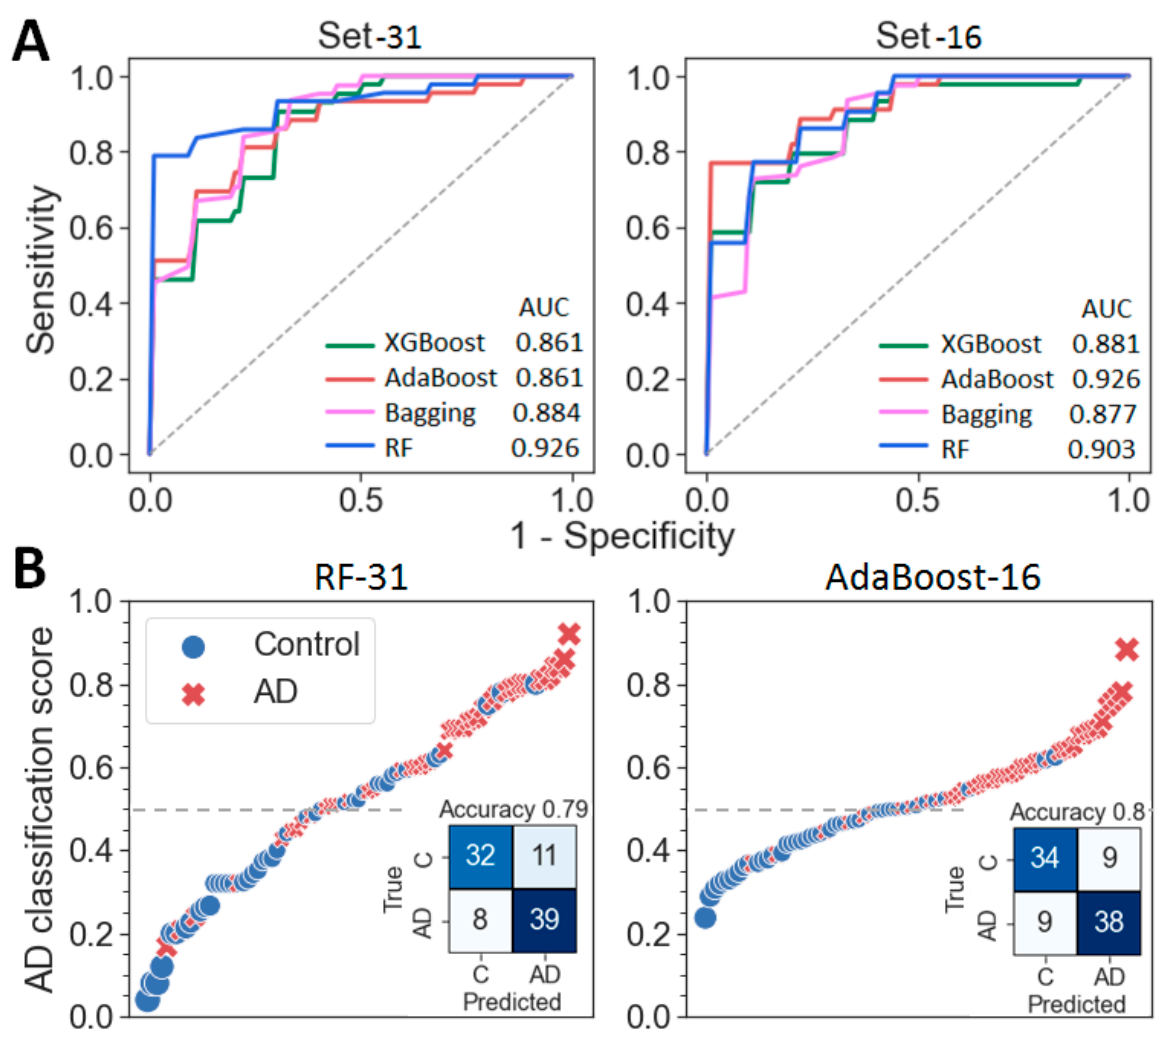
Figure 4. Differentiation of the AD and control samples using the obtained protein panels and developed classifiers. ( A ) ROC curves for the differentiation of AD vs. the controls for classifiers generated with 4 algorithms and 2 sets of proteins. ( B ) Distribution of the control and AD samples according to the probability of AD using two classifiers with the best performances.